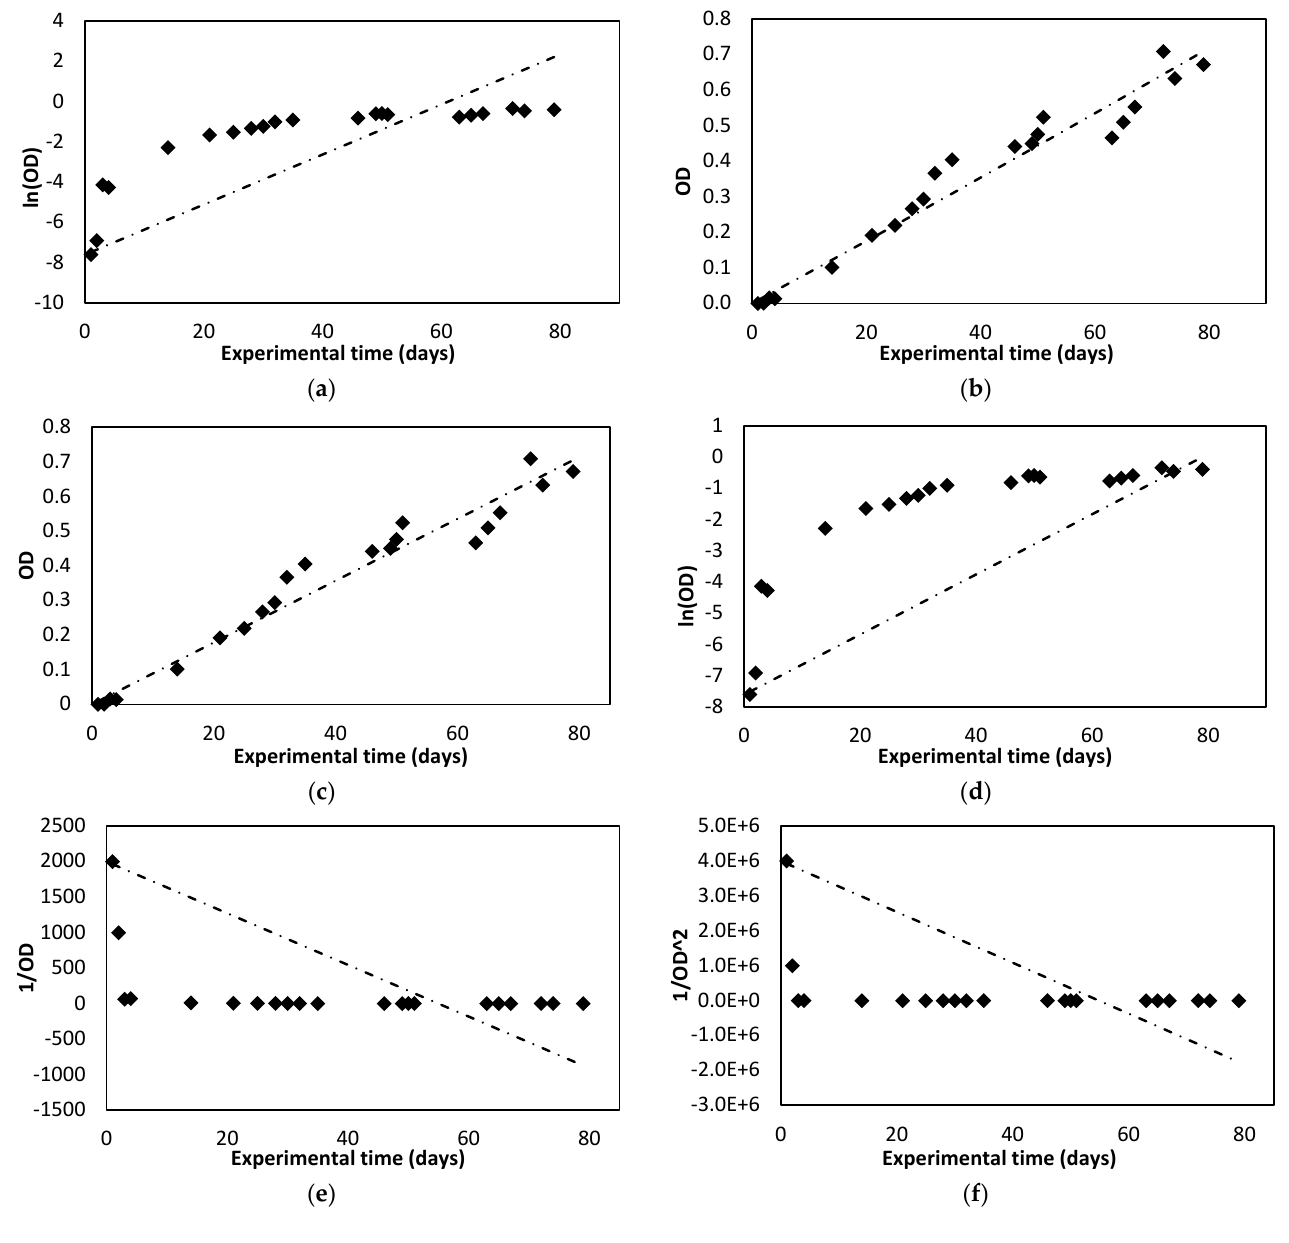
Figure 6. Fitting data for optical density (OD) (absorbance at 680 nm) to each kinetic model assessed. (a) Pseudo-first order. (b) Pseudo-second-order. (c) Zero order. (d) First-order. (e) Second-order. (f) Third order.